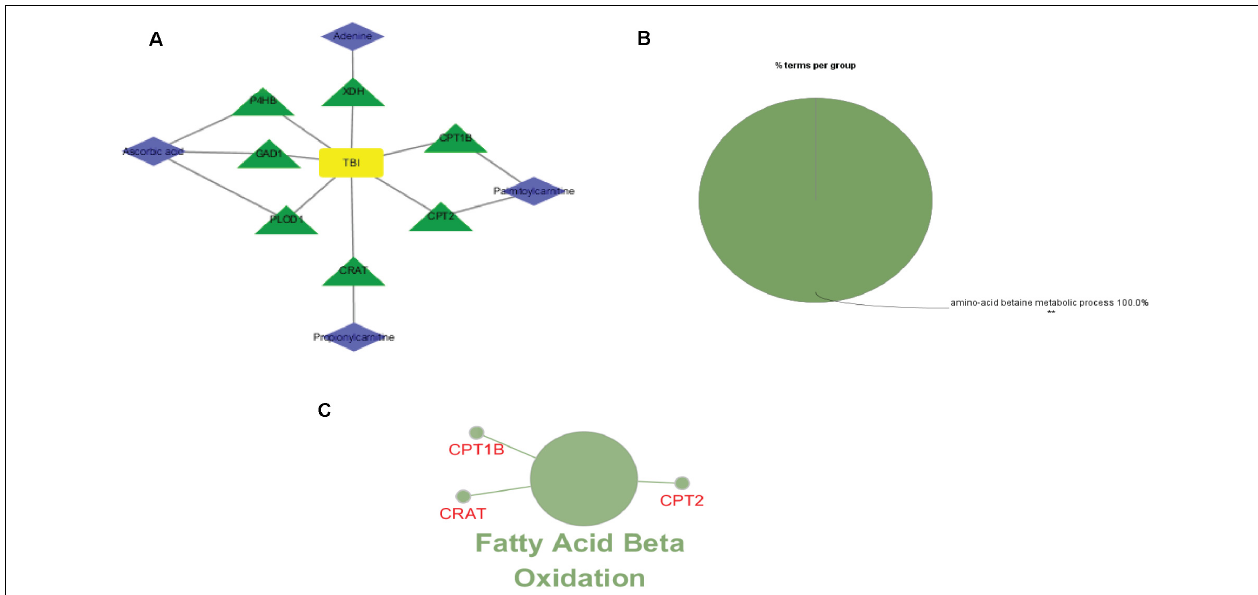
FIGURE 11 | Perspective of traumatic brain injury (TBI) perturbation on integrated proteins, hippocampal metabolites, and pathway: (A) network of TBI-causing candidate proteins (green and triangle) and hippocampal metabolites (blue and diamond). (B) Gene Ontology analysis of seven hippocampal metabolite-related proteins. (C) A subnetwork of three proteins enriched in fatty acid beta oxidation.